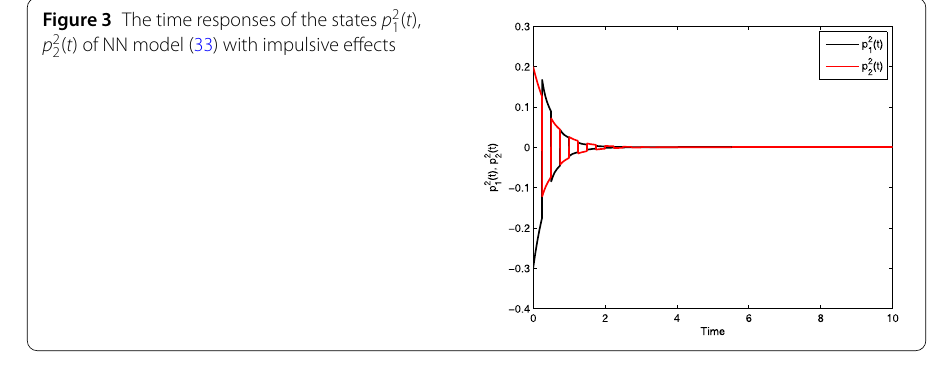
Figure 3 The time responses of the states p 2 1 ( t ), p 2 2 ( t ) of NN model (33) with impulsive effects